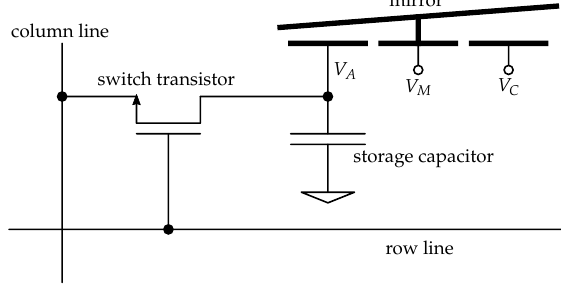
Figure 4. Schematic of a pixel